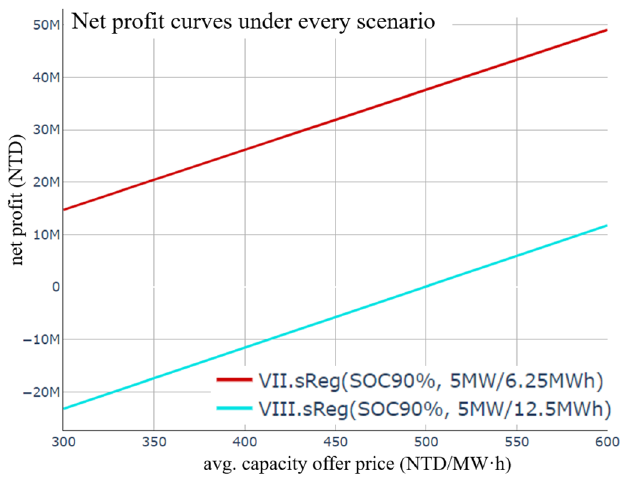
Figure 25. Net profit under different C-rates (sReg).